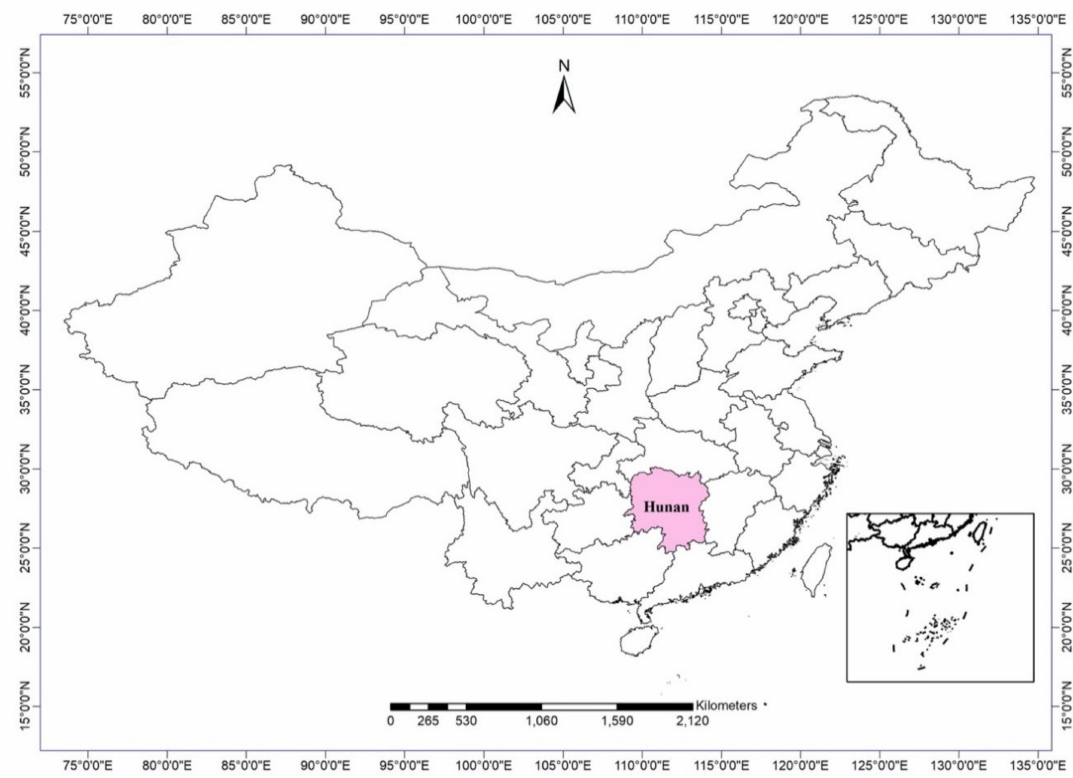
Figure 1. Geographical position of Hunan Province,